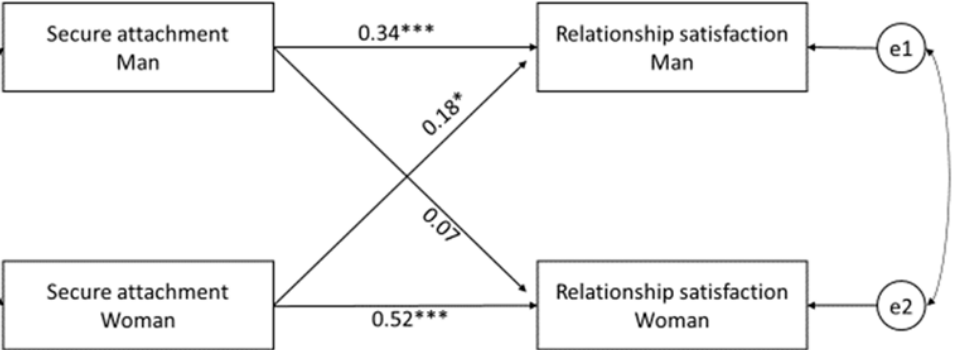
Figure 2. Secure attachment and relationship satisfaction (Model 1). Rectangles = independent and dependent variables; two circles = latent error terms (e1, e2: residual errors on satisfaction for males and females, respectively); the arrows = the actor and partner effects. The curved double-headed arrows on the left = covariances between the independent variables; the curved double-headed arrow on the right = correlation between the two error terms; * p < 0.05; *** p < 0.001.